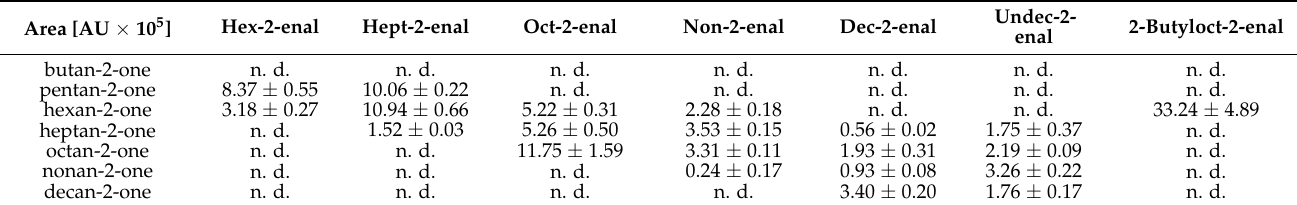
Table 8. Peak areas of methyl ketones from different alk-2-enals (0.05% in paraffin oil) with PE, heated at 160 ◦ C for 20 min and analyzed by HS-GC-MS; n. d. = not detected. Area [AU × 10 5